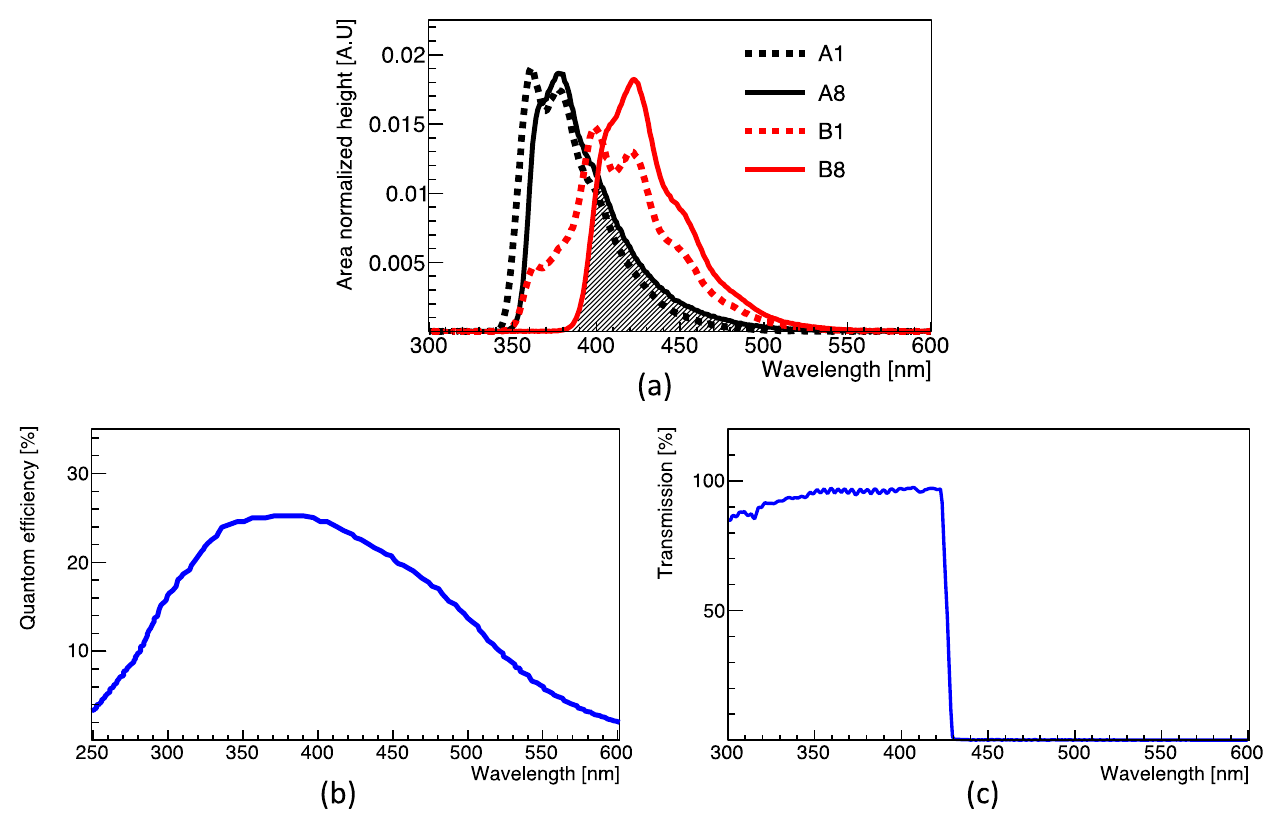
Figure 2. ( a ) Emission spectra of the LS samples with different PPO and bis-MSB concentrations. (Black lines) The PPO concentration is 0.5 g/L (A1) or 10 g/L (A8). (Red lines) The PPO concentration is 3 g/L and the bis-MSB concentration is 1 mg/L (B1) or 50 mg/L (B8); ( b ) Wavelength-dependent photon detection efficiency of the H7195 PMT [17] ; ( c ) Transmittance of the short-pass-filter as a function of the wavelength.